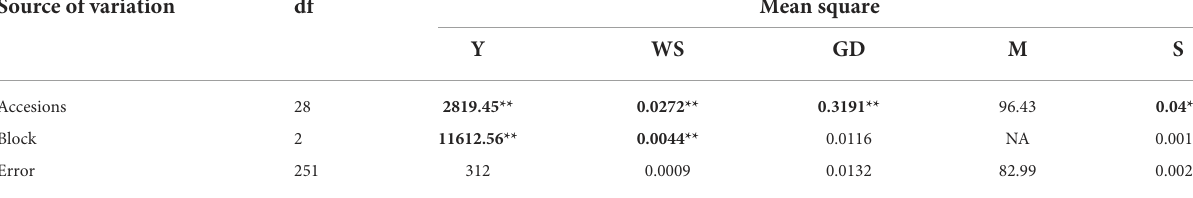
TABLE 5 Analysis of variance between the evaluated quinoa materials, for Type I error. Source of variation